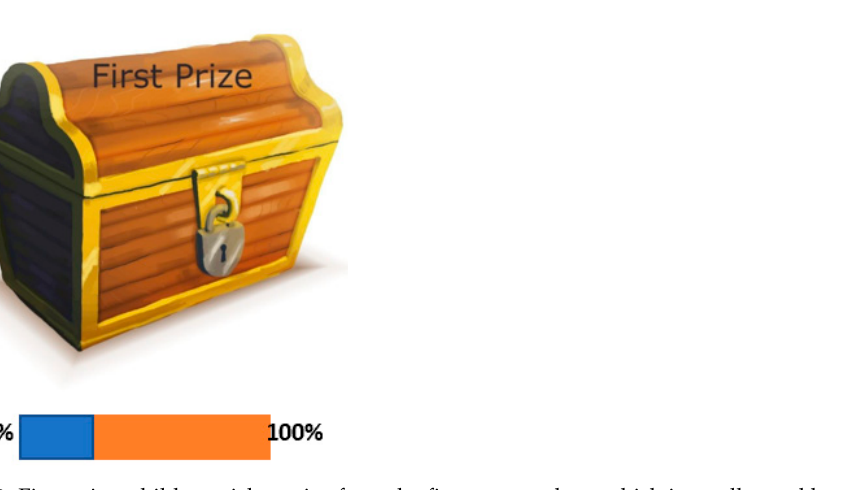
Figure 2. First prize: children pick a prize from the first treasure box, which is smaller and has fewer options than the second one.